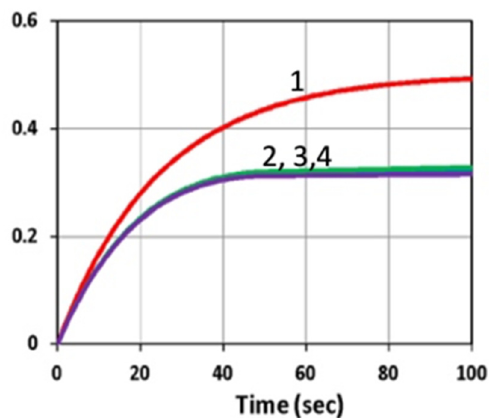
Figure 7. The same as Figure 6, but for a fixed difference of [b 1 C 10 − b 2 C 20 ] = 0.003, for C 20 = 0 (curve-1) and C 20 > 0, for curves (2,3,4) showing the overlapping of these three curves.